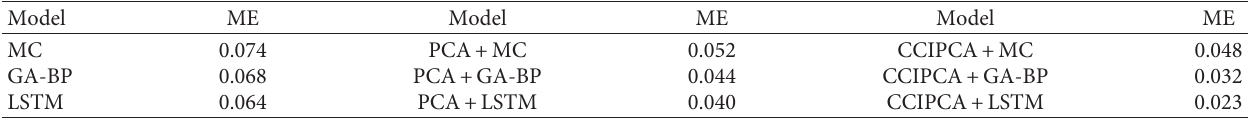
Table 5: ME comparison between